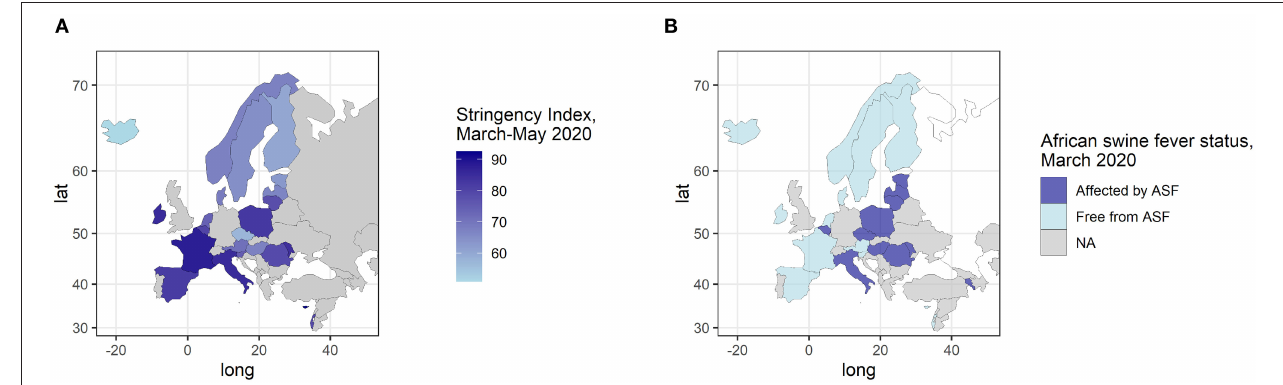
FIGURE 1 | Context of the study in the 24 responding countries. (A) Stringency index of the COVID-19 government response over the period March-May 2020 computed from the Oxford COVID-19 Government Response Tracker (OxCGRT) dataset (3) (no data available for Armenia); (B) African swine fever status of the 24 responding countries in March 2020 (start of the study